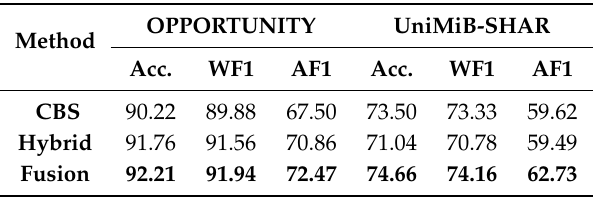
Table 10. Performance metrics (in percent) of the codebook approach with soft-assignment, hybrid CNN and LSTM approaches, and their fusion on the OPPORTUNITY and UniMiB-SHAR